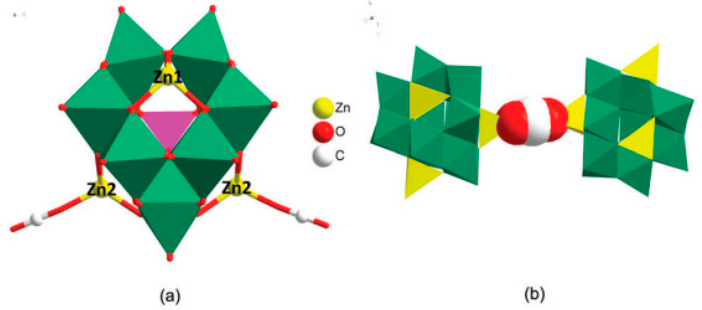
Figure 17. The basic building blocks ( a ) and coordination model of CO 2 ( b ) in [PMo 12 O 40 Zn 4 (CO 2 )] 2 − . Color code: Zn, yellow ball; O, red ball; C, white ball; MoO 6 octahedra, green; PO 4 tetrahedron, magenta. Reprinted with permission from [19]. © 2018 The Royal Society of Chemistry.